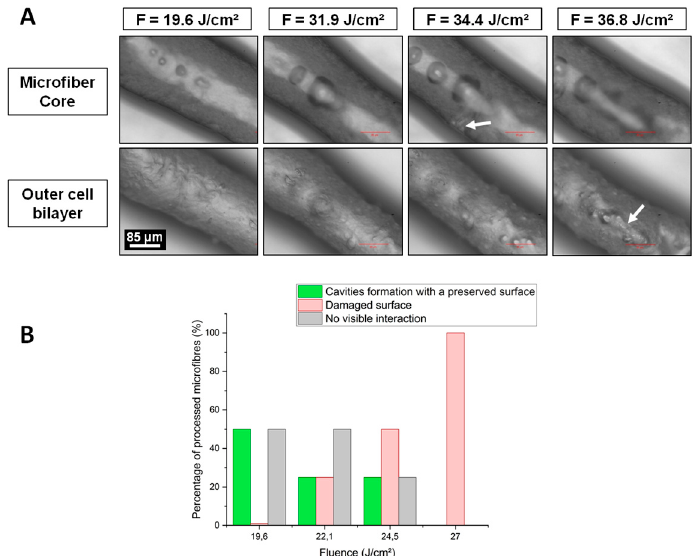
Figure 3. ( A ) One microfibre processed at four different fluence values: F = 19.6; 31.9; 34.4, and 36.8 J · cm − 2 , Top: microfibre core, Bottom: outer cell bilayer. Cavitation bubbles were imaged within the collagen hydrogel at the processing depth (90 µ m). Fixed parameters: λ = 1030 nm; D = 90 µ m; R.R. = 50 kHz; O.L. = 99.7%; 1 laser pass. White arrows indicate significant cell wall damages. ( B ) Evolution of the microfibres number (%) with respect to the type of laser-induced modifications observed 24h after laser processing for different fluence values. A schematic illustration of focal point positions for different depth of focus values inside a 200 µ m diameter microfibre. Red gradient cones map the laser fluence gradient before and after focalization. The further away from the focal volume, the lower the laser fluence.